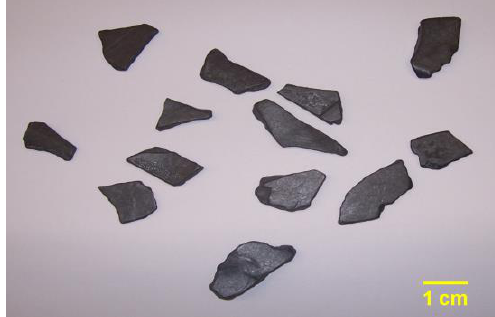
Figure 2. Samples of vehicle polymer materials.